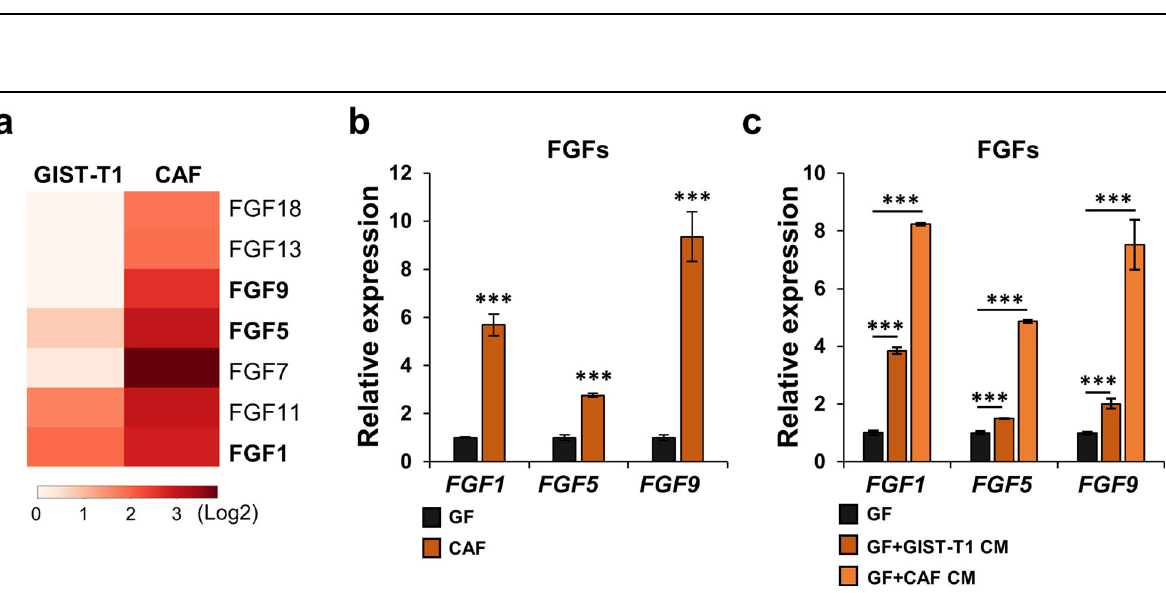
Fig. 1 GIST cells and CAFs enhance a GF-to-CAF transition. a The images of gastric fi broblasts (GFs) and GIST-CAFs. Scale bars, 50 µm. b Expression of PDGFC mRNA in GFs and CAFs by quantitative RT-PCR (qPCR). c The effects of GIST-T1 conditioned media (CM) and CAF CM treatment on PDGFC expression in GFs. After GFs were treated with CM of GIST-T1 and CAFs for 48 h, the expression level of PDGFC was determined by qPCR. d Expression of CAF markers ( CCL2 , RAB3B , and TNC ) in GFs and CAFs by qPCR. e The effects of GIST-T1 CM and CAF CM treatment on CAF markers expression in GFs. All graphs show mean ± SEM, and p values were represented by Student ’ s t test or ANOVA analysis. ** p < 0.01, *** p < 0.001. f Phosphokinase array in GIST-T1 treated with CAFscr CM, CAFshPDGFC #1 CM, or CAFshPDGFC #2 CM. g The average signal (pixel density) was normalized with positive control and analyzed among samples. All graphs show mean ± SEM, and p values were represented by ANOVA analysis. * p < 0.05; ** p < 0.01.